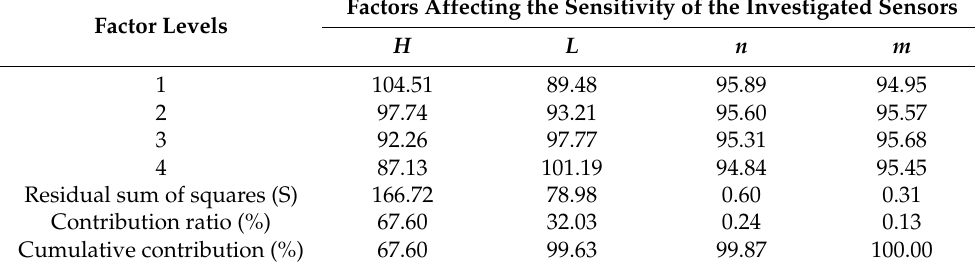
Table 4. The Pareto ANOVA table for sensitivity. Factor Levels